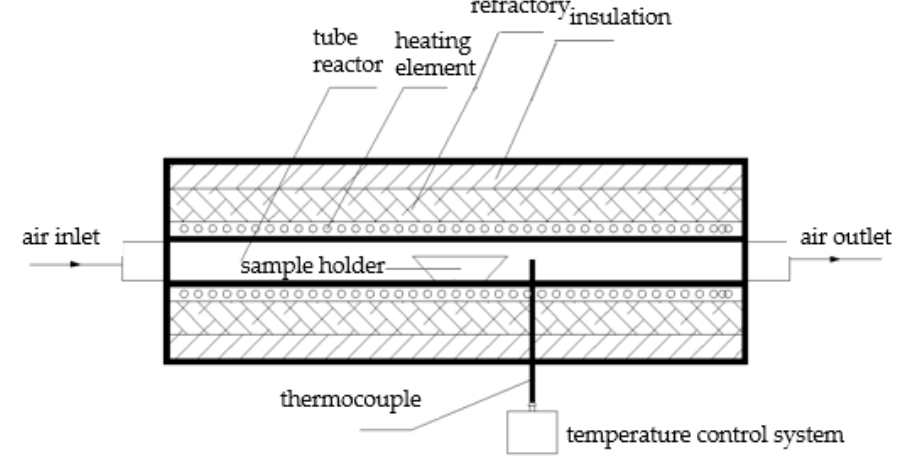
Figure 1. Schematic diagram of experiment setup.